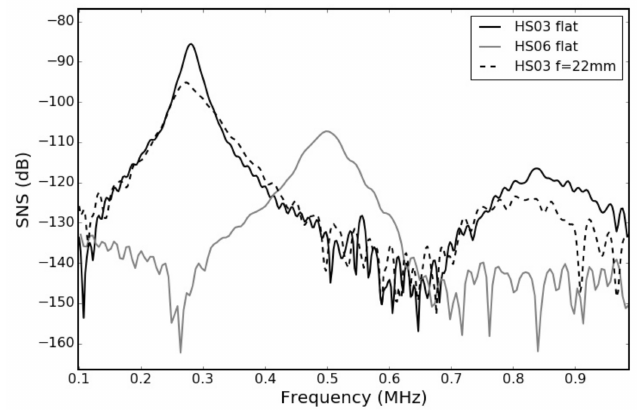
Figure 4. Au-sputtered transducers in pulse-echo response, air-coupled